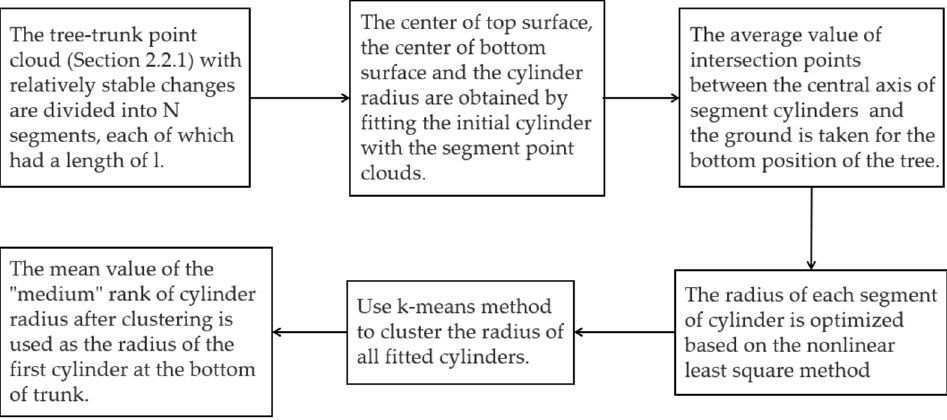
Figure 9. The process of tree branch structure fitting and optimization.